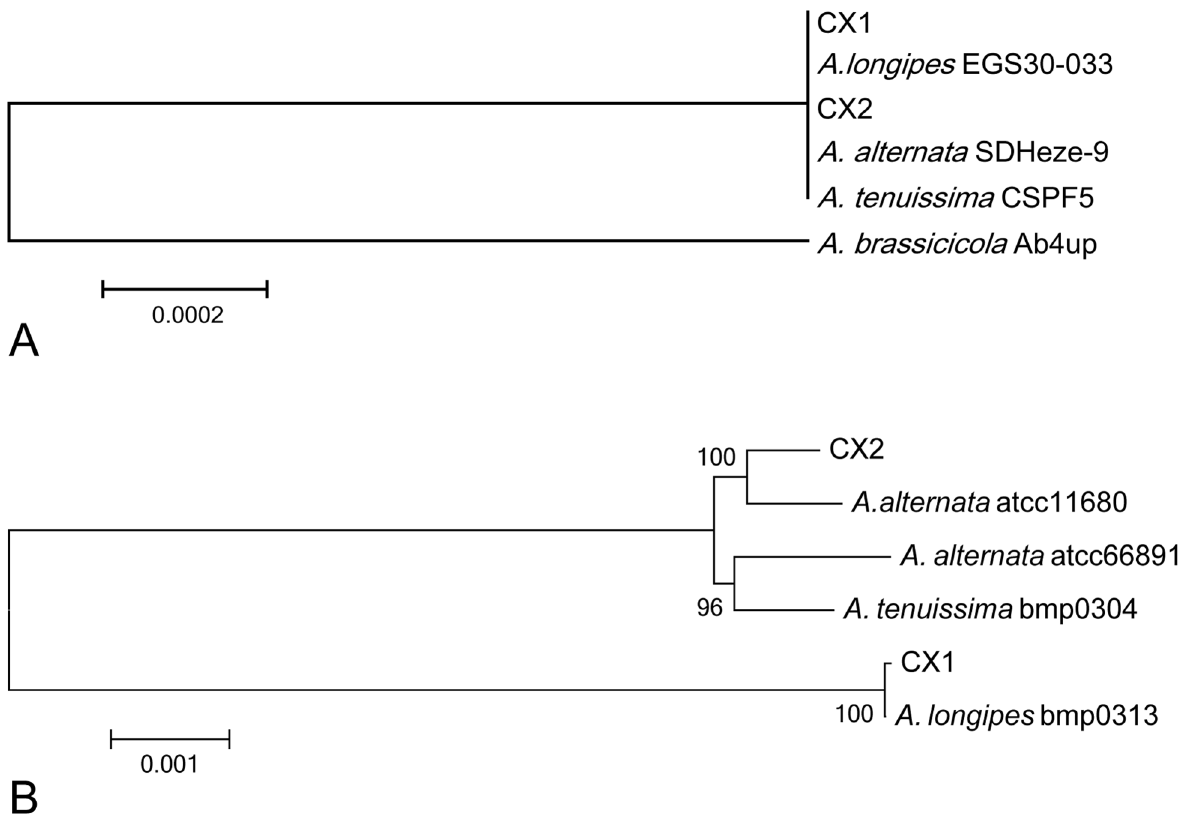
Fig 3. Phylogenetic relationship between CX1 and CX2. (A) Phylogenetic relationship constructed by MEGA5 based on ITS sequences of CX1, CX2, A . longipes EGS30-033, A . alternata SDHeze-9, A . tenuissima CSPF5 and A . brassicicola Ab4UP. (B) Phylogenetic relationship constructed by MEGA5 based on large co-linear sequence among CX1, CX2, A . alternata atcc11680, A . longipes bmp0313 and A . tenuissima bmp0304.